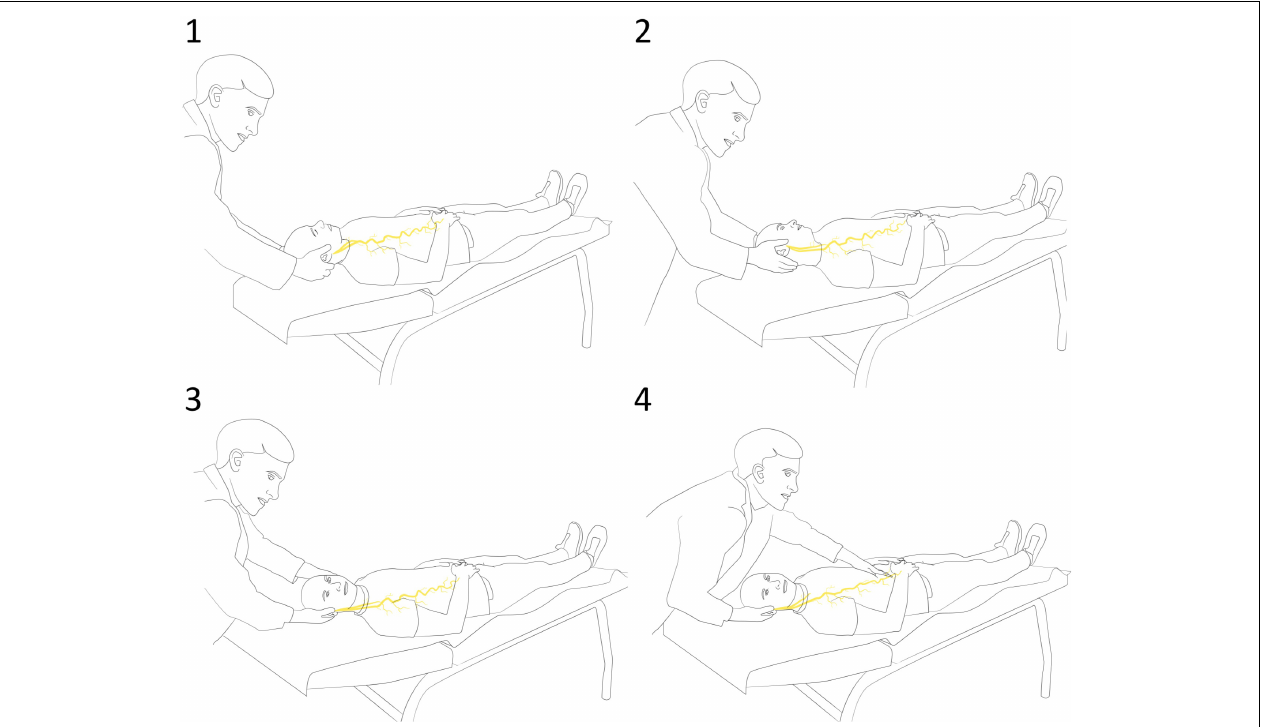
FIGURE 1 | Sequence of the vagus nerve neurodynamic test (VN-NDT) with (1) starting position with upper cervical spine in flexion. (2) Contralateral lateral flexion. (3) Ipsilateral neck rotation. (4) The end position of the test with gentle movements of the upper abdomen caudally and cranially as discrimination